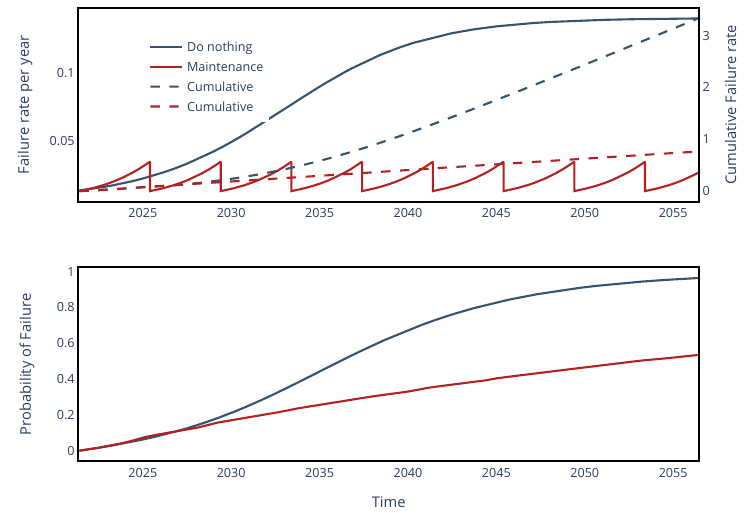
Figure 17. Influence of the optimal TR_1 maintenance strategy on its failure rate and